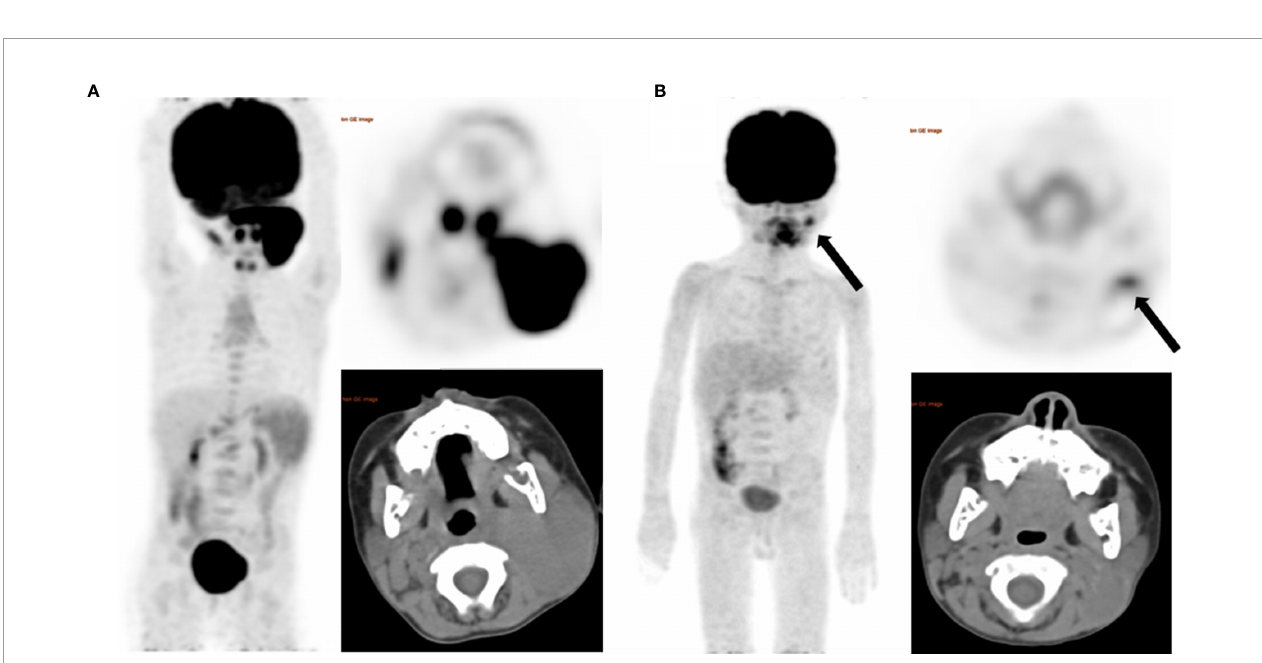
FIGURE 2 | A representative case of a 4-year-old female with stage IIIB BL and nodal disease. Baseline maximum intensity projection (MIP) (A) showing hypermetabolic lesion in cervical nodes. End of treatment PET/CT (B) showing moderate 18F-FDG uptake residual lesion in the cervical node (SUVmax = 4.1), considering Deauville score of 4 and a partial response. And the residual lesion dissection was performed, proving no viable lymphoma cell. After a follow up time of 62 months, this patient did not develop relapse and was